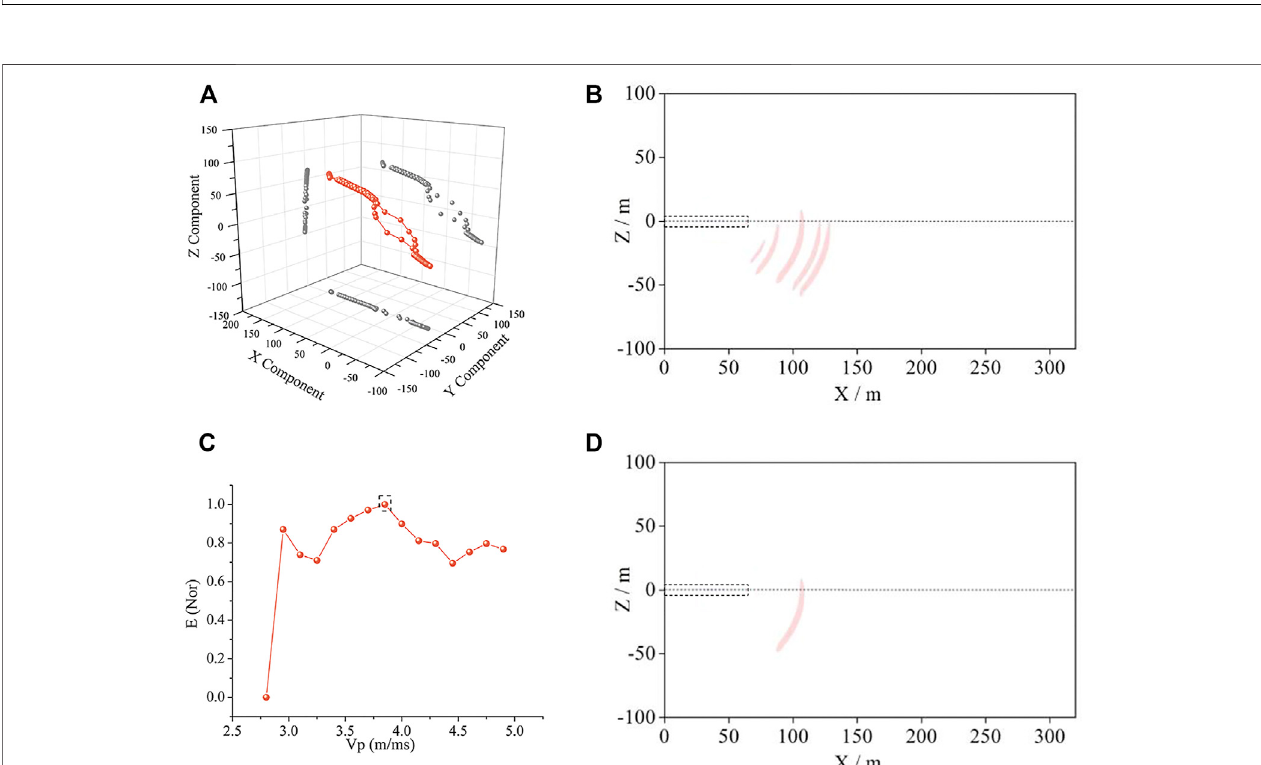
FIGURE 6 | Polarization migration results of the fi rst interface. (A) represents the particle vibration of No. 2 receiver, whose principal polarization angle is − 25 ° . The polarization migration results in (B) are obtained by superposing all the 16 receivers. Since the migration results corresponding to 15 velocities (in part (C) ) are dif fi cult to display,thepolarizationmigrationinterfacescorrespondingto fi vevelocitiesatrelativelylargeintervalsareselected.AccordingtothevelocityofVpin (C) andtheprinciple polarization angle in (A) , polarization migration interface is con fi rmed.